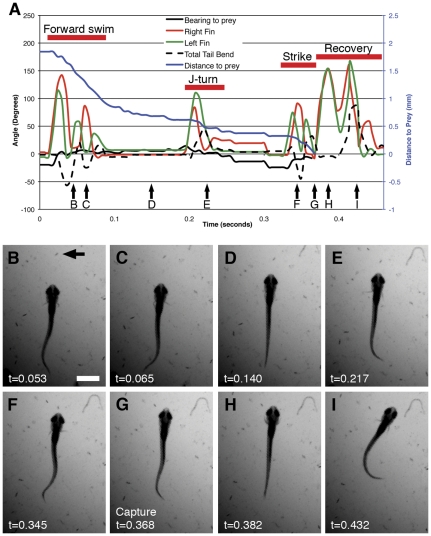
Components of prey capture.The chart in panel A shows a larva's pursuit and capture of a paramecium (arrow, B). The individual elements of the behavior are indicated by red lines. Panels B–I show individual frames from the movie of this sequence, with approximate times of the frames indicated by arrows in Panel A. The paramecium is indicated with an arrow in panel B, and all panels show the same field of view. Panels B and C show opposite tail bends of a forward swim, with extensions of the outside pectoral fin in each case. The larva pauses in panel D. Panel E shows the unilateral tail bend typical of a J-turn, with the outside pectoral fin extended. An S-bend is seen in panel F, which leads to the capture of the paramecium in panel G. Strong abductions of both pectoral fins are seen immediately after capture (Panel H), before the larva turns and swims away (Panel I). Time stamps are shown for each panel. The scale bar in B represents 1 mm. The larva shown is 7 dpf.